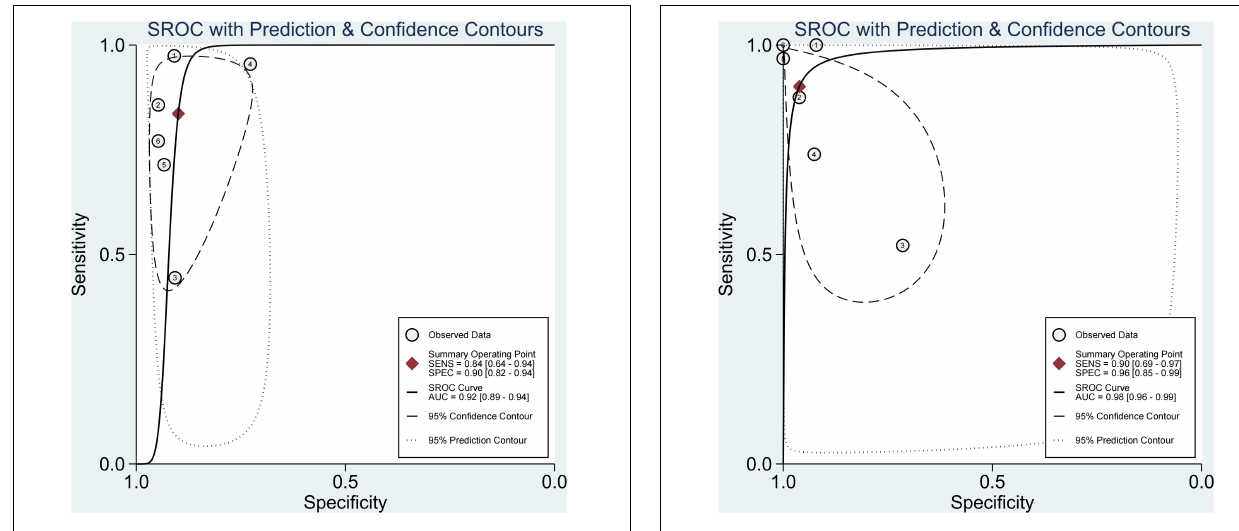
and dietary habits (5), and controversy existed in the limited number of studies. He et al. found that the serum upregulated levels of cytokeratin-18 (CK-18) and fibroblast growth factor-21